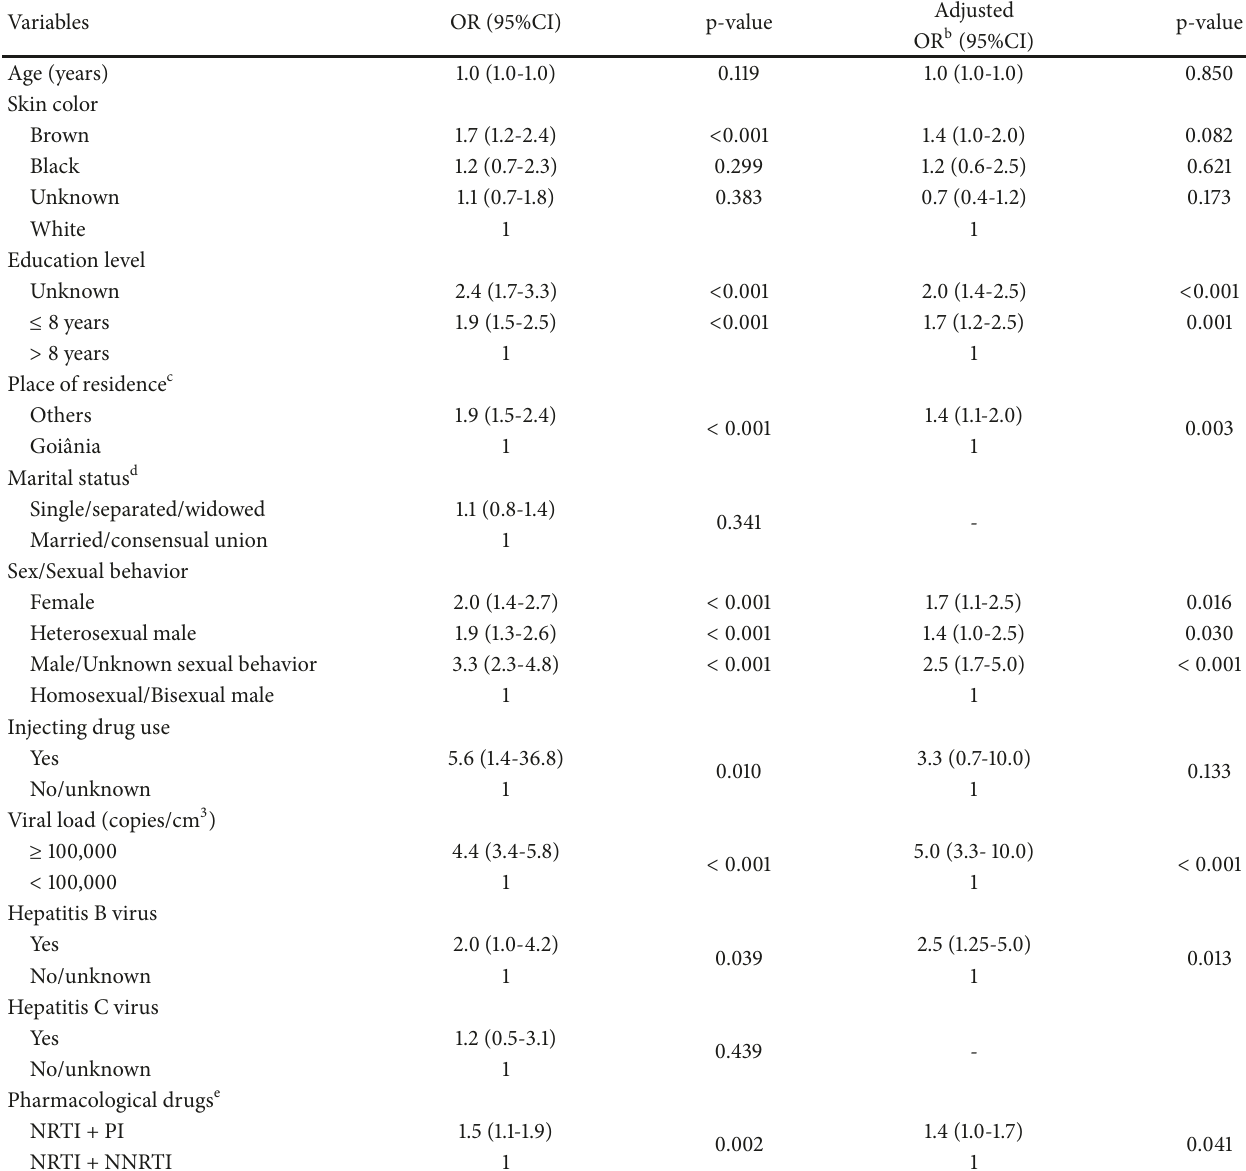
Table 3: Univariate and multivariate analysis of factorsassociated with late initiation a of antiretroviral therapy among 1,141 people living with HIV,